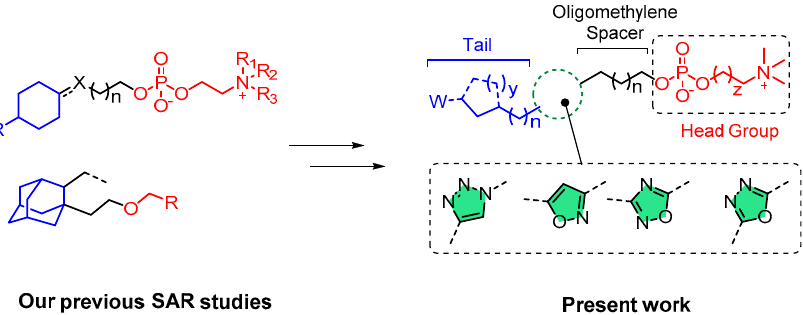
Figure 1. General structures of the compounds synthesized in the past and in the present work.